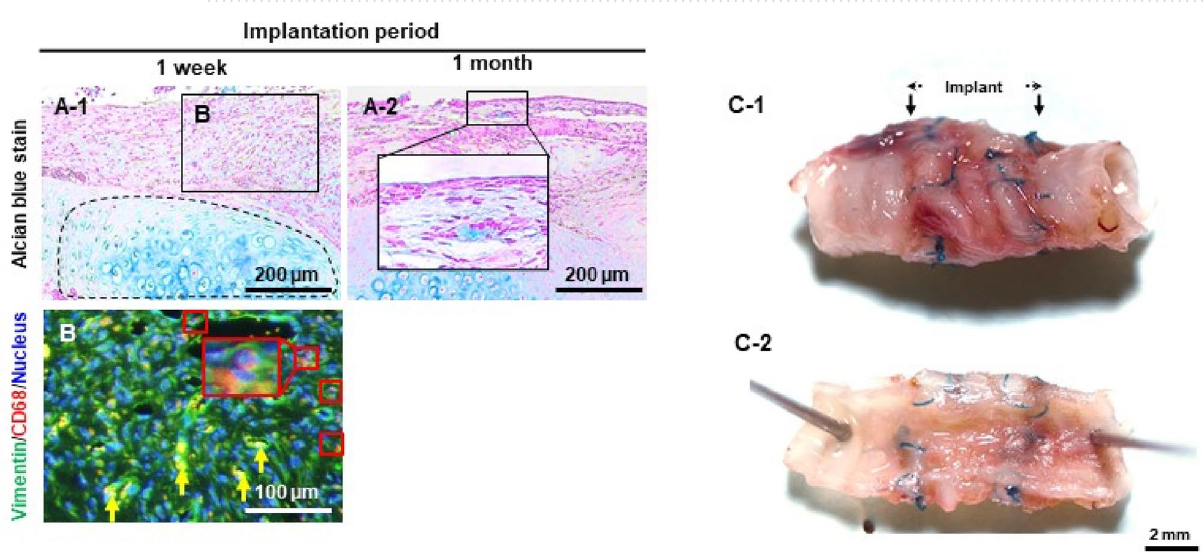
Figure 3. Histological analysis of tracheal analogue implants in the subacute phase. The sections of tracheal analogues implanted after 1 week ( A-1 and B ) and 1 month ( A-2 ) stained with alcian blue dye ( A-1 and A-2 ) and vimentin and CD68 antibody ( B ). Macroscopic view of the tracheal analogue after implanting for one month at outer surface ( C-1 ) and lumen ( C-2 ). The dashed circles in ( A-1 ) indicate the cartilage rings. The yellow arrows and red flames in B indicate erythrocytes in capillaries, identified by yellow fluorescence arising from overlapping of red and green autofluorescence, and CD68-positive cells,